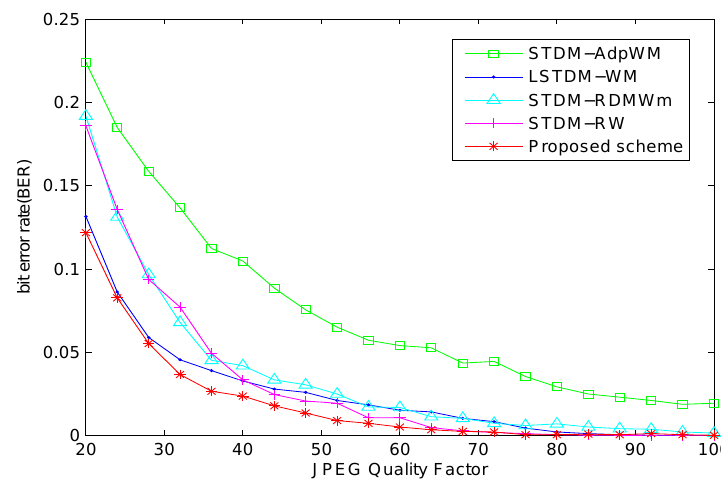
Figure 7. BER versus JPEG compression for different watermarking algorithms with VSI = 0.982.